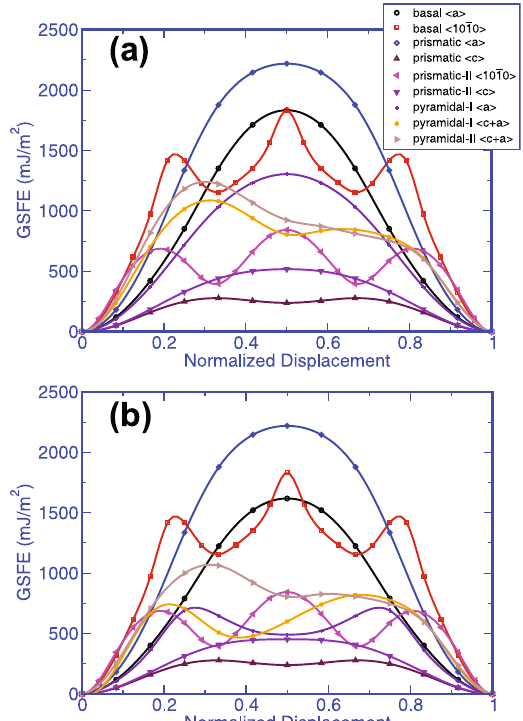
Figure 2. Comparison of the DFT calculated GSFE curves for all nine slip modes in ω -Zr obtained from the ( a ) SR calculations and ( b ) AR calculations. The x-axis displacement shift corresponds to the actual displacement along the glide direction normalized by the full Burgers vectors for each slip